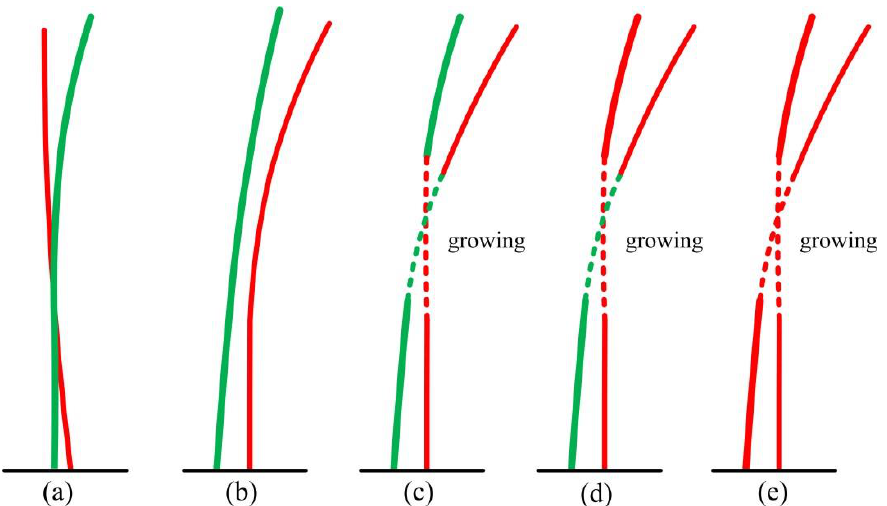
Figure 7. Error types: ( a ) Bamboos are too close to each other; ( b ) two independent stems; ( c ) mutual containment of two stems after growing; ( d ) one stem (in red) contains part from the other one; and ( e ) two stems are totally merged as one.